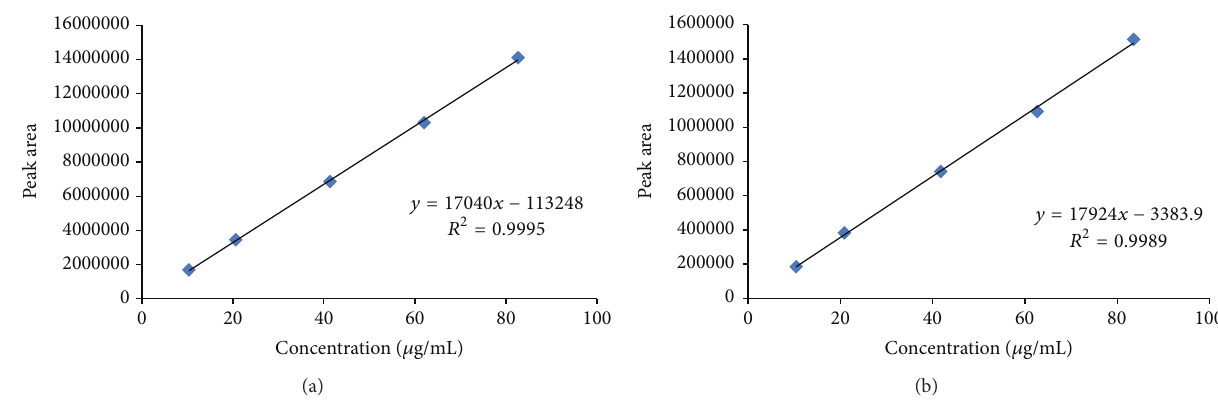
Figure 2: Concentration versus peak area curve for RC (a) and DP (b)